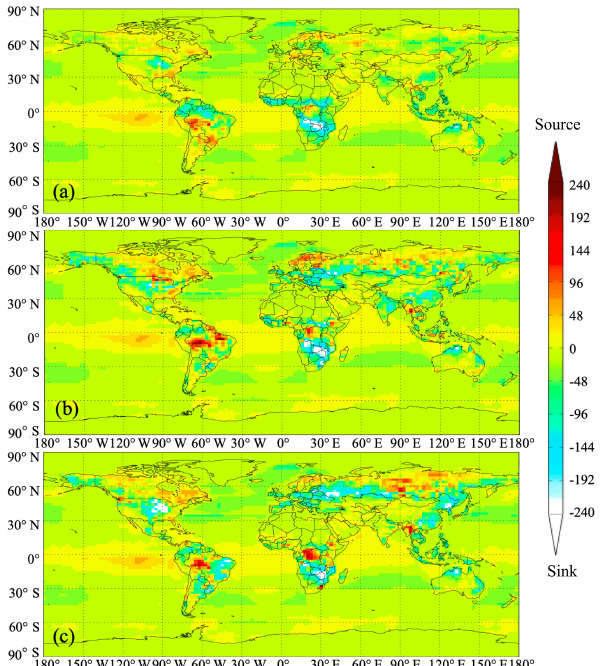
Figure 5. Distributions of annual land and ocean carbon fluxes; (a) prior flux and posterior fluxes based on (b) OCO-2 and (c) GOSAT data (gCm − 2 yr − 1 )